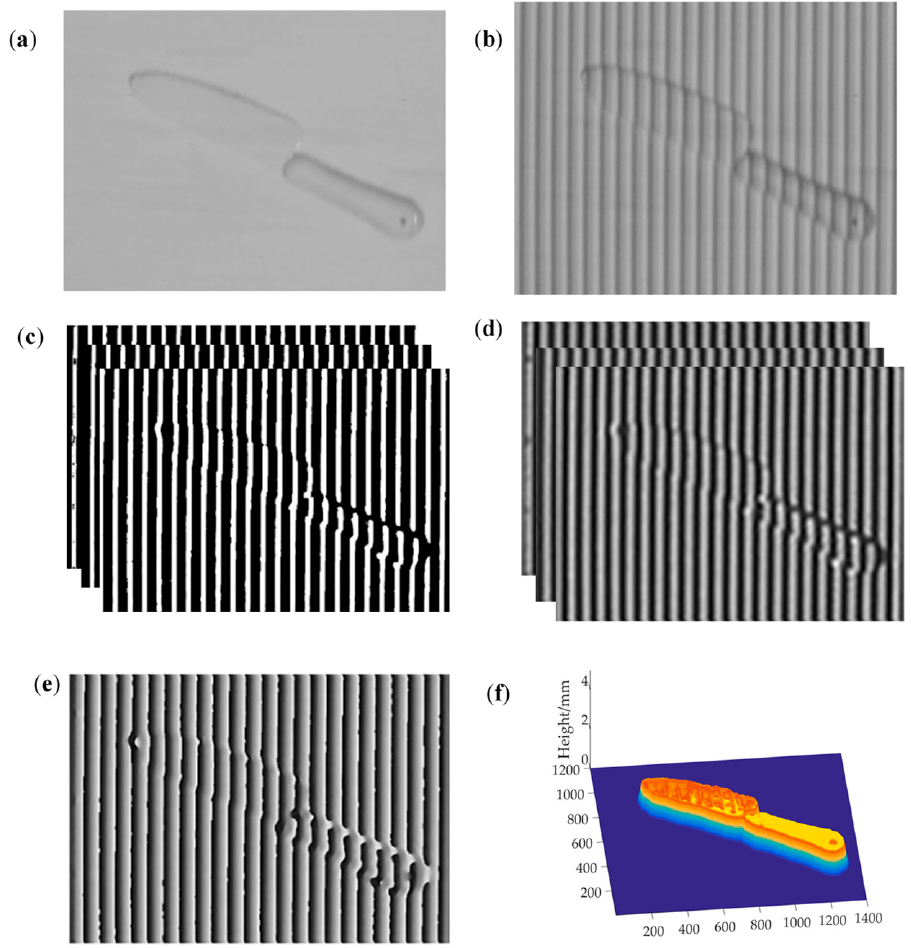
Figure 9. Knife measuring experiment: ( a ) the knife; ( b ) captured deformed patterns; ( c ) the bi- nary deformed patterns; ( d ) extracted sinusoidal deformed patterns; ( e ) wrapped phase; and ( f ) reconstructed result.